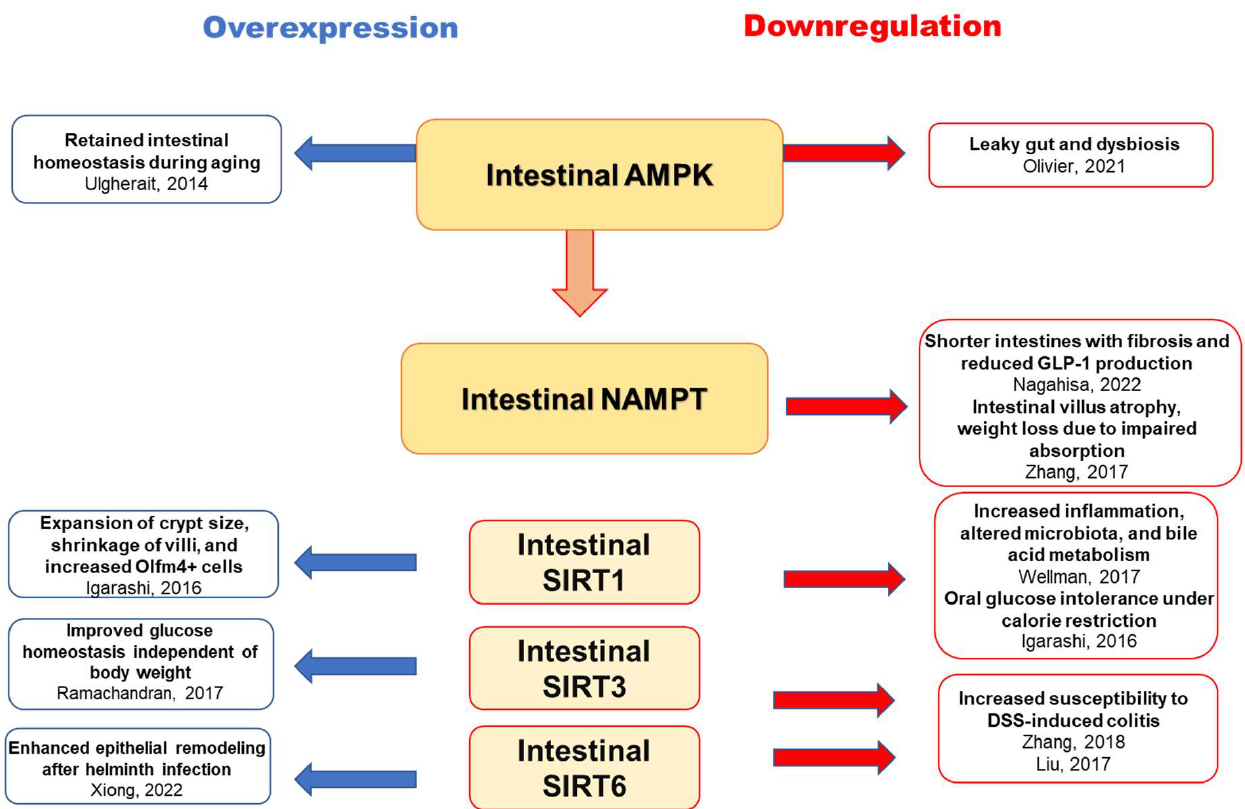
Figure 2. Intestinal phenotype induced by the overexpression or knockout of the intestinal AMPK- NAMPT-NAD + -sirtuin pathway [31,87,94,95,98,101–105]. Olfm4—olfactomedin 4.